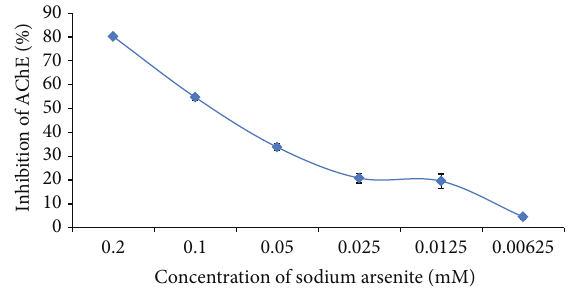
Figure 1: The effect of sodium arsenite on the activity of acetyl- cholinesterase in vitro . Values are presented as mean ± SD.